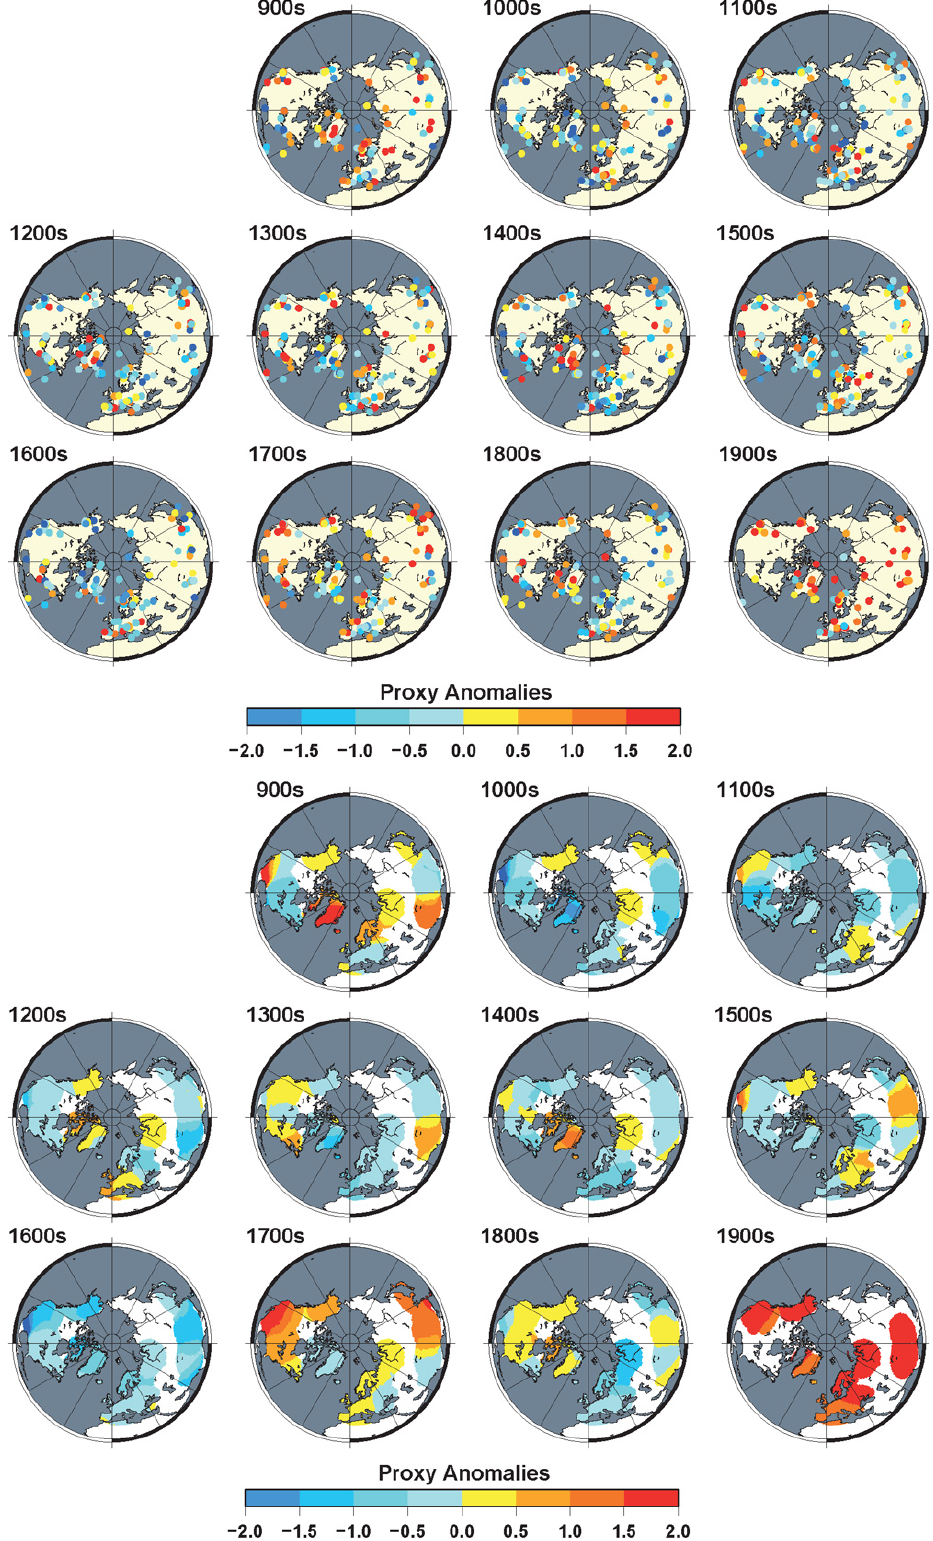
Fig. 5. Centennial first-differences between each century and the previous. Upper panel: differences for raw centennial proxy anomaly values as shown in Fig. 2. Lower panel: gridded, weighted, centennial anomaly values for the same data. The colour scale in both panels is truncated at − 2 and